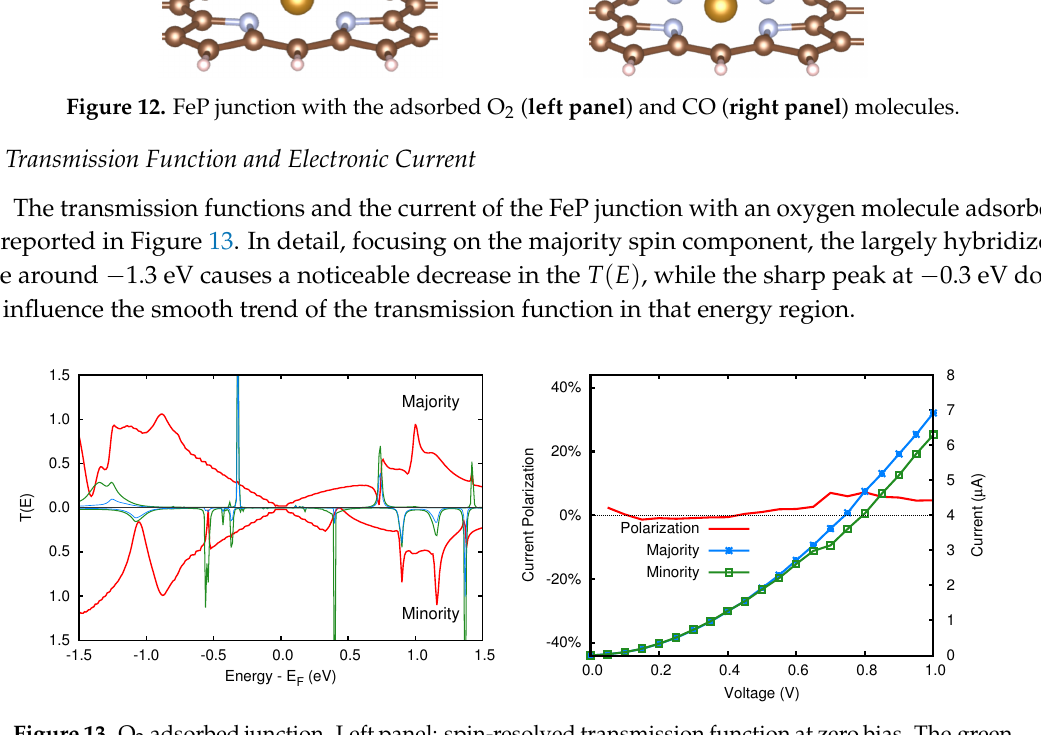
Figure 13. O 2 adsorbed junction. Left panel: spin-resolved transmission function at zero bias. The green line represents the density of states projected on both the O 2 molecule and iron atom, while the blue one only on the latter. Right panel: spin-resolved electronic current and current